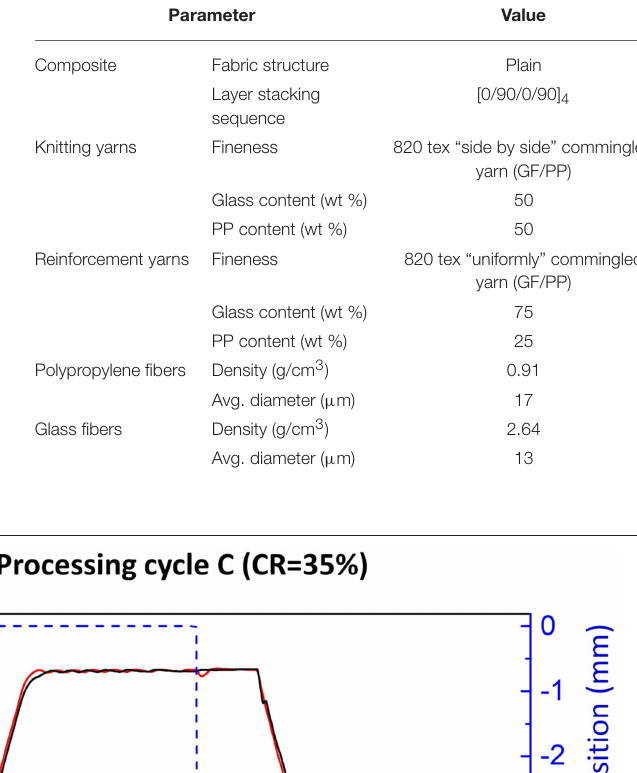
TABLE 1 | Parameters of the biaxial weft-knitted fabric.